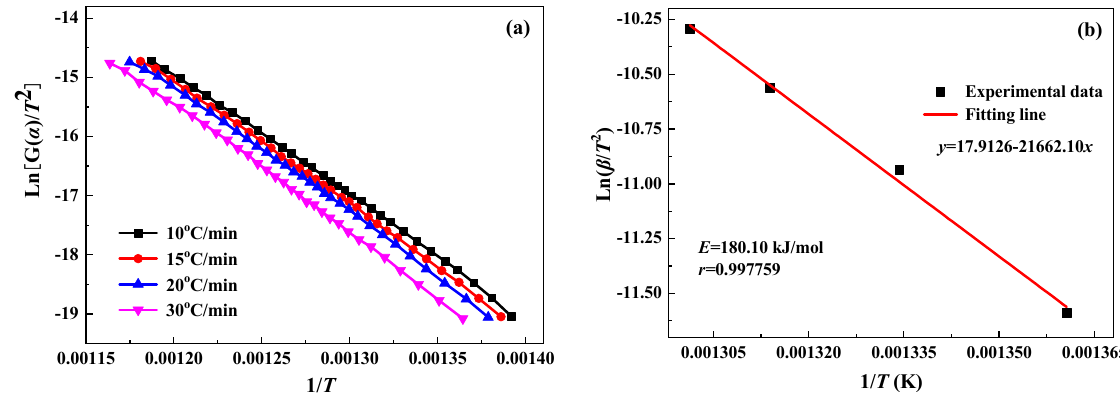
Figure 6. Conversion rate curves.